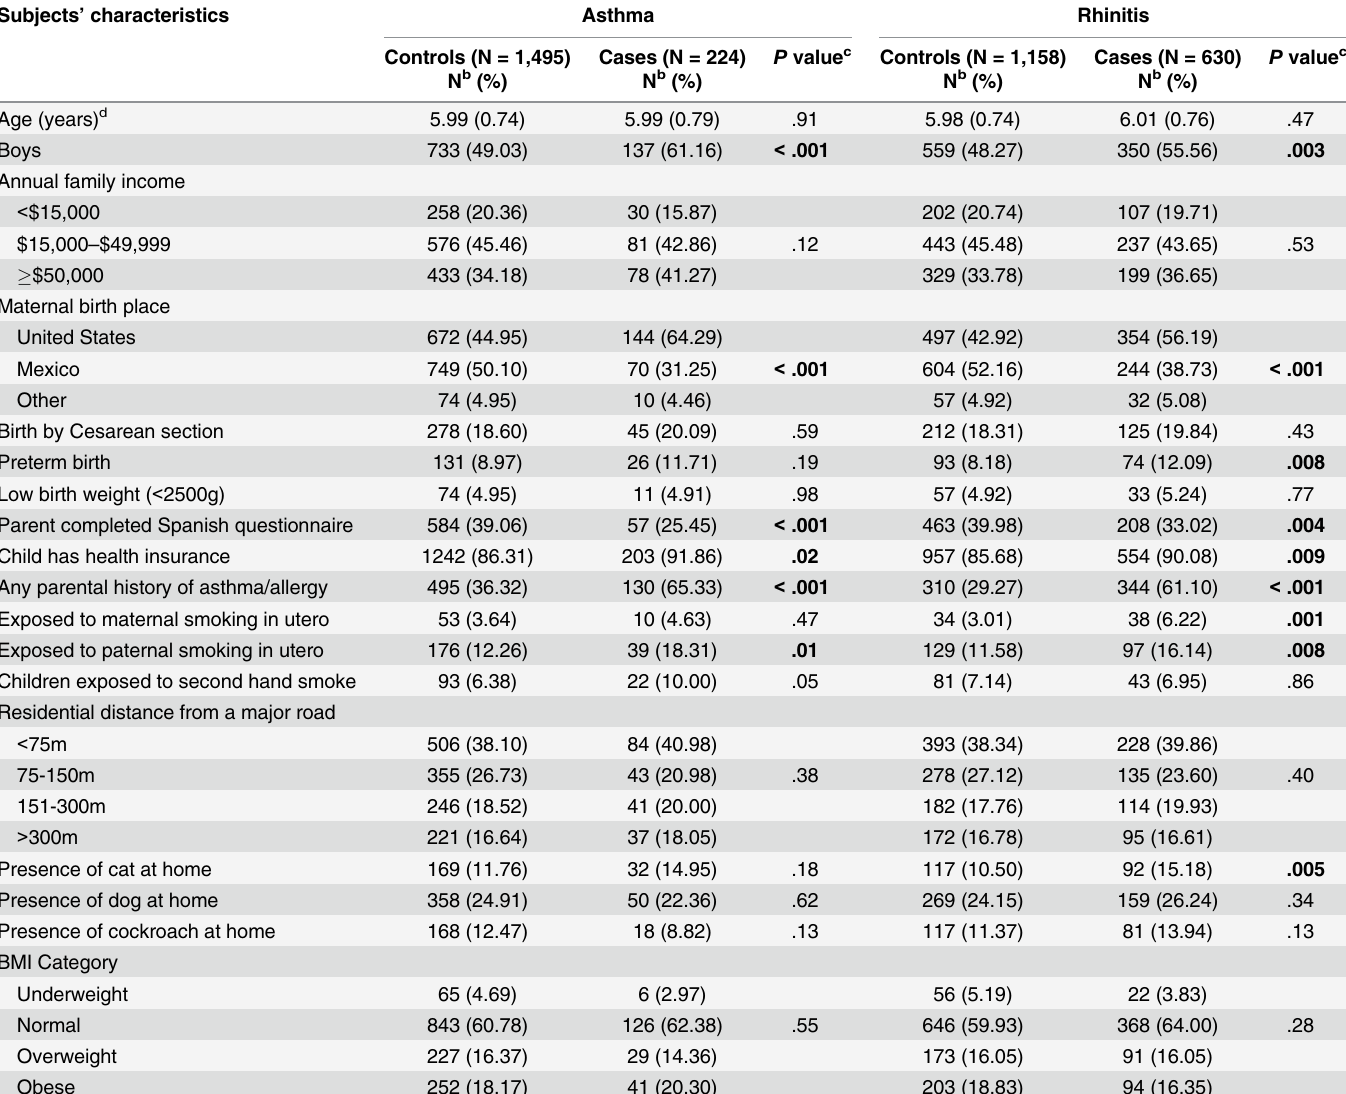
Table 1. Characteristics of California-born Hispanic Participants in Children ’ s Health Study by Asthma and Rhinitis Status. a